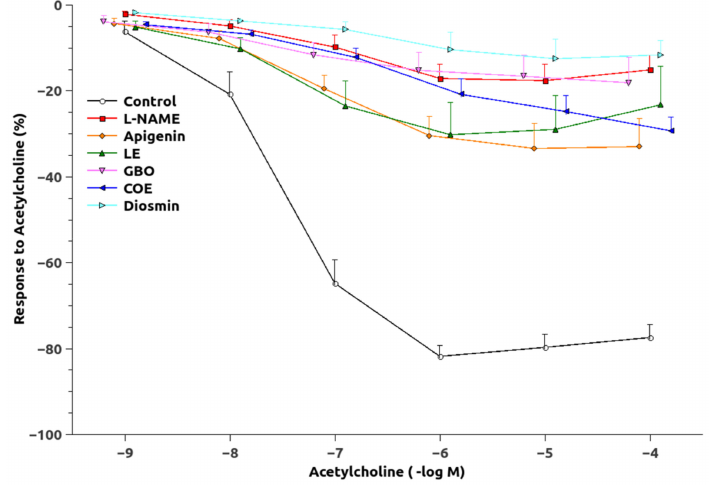
Figure 4. Vasodilatory response to acetylcholine in phenylephrine-preconstricted aortic rings. Abbreviations as in Figure